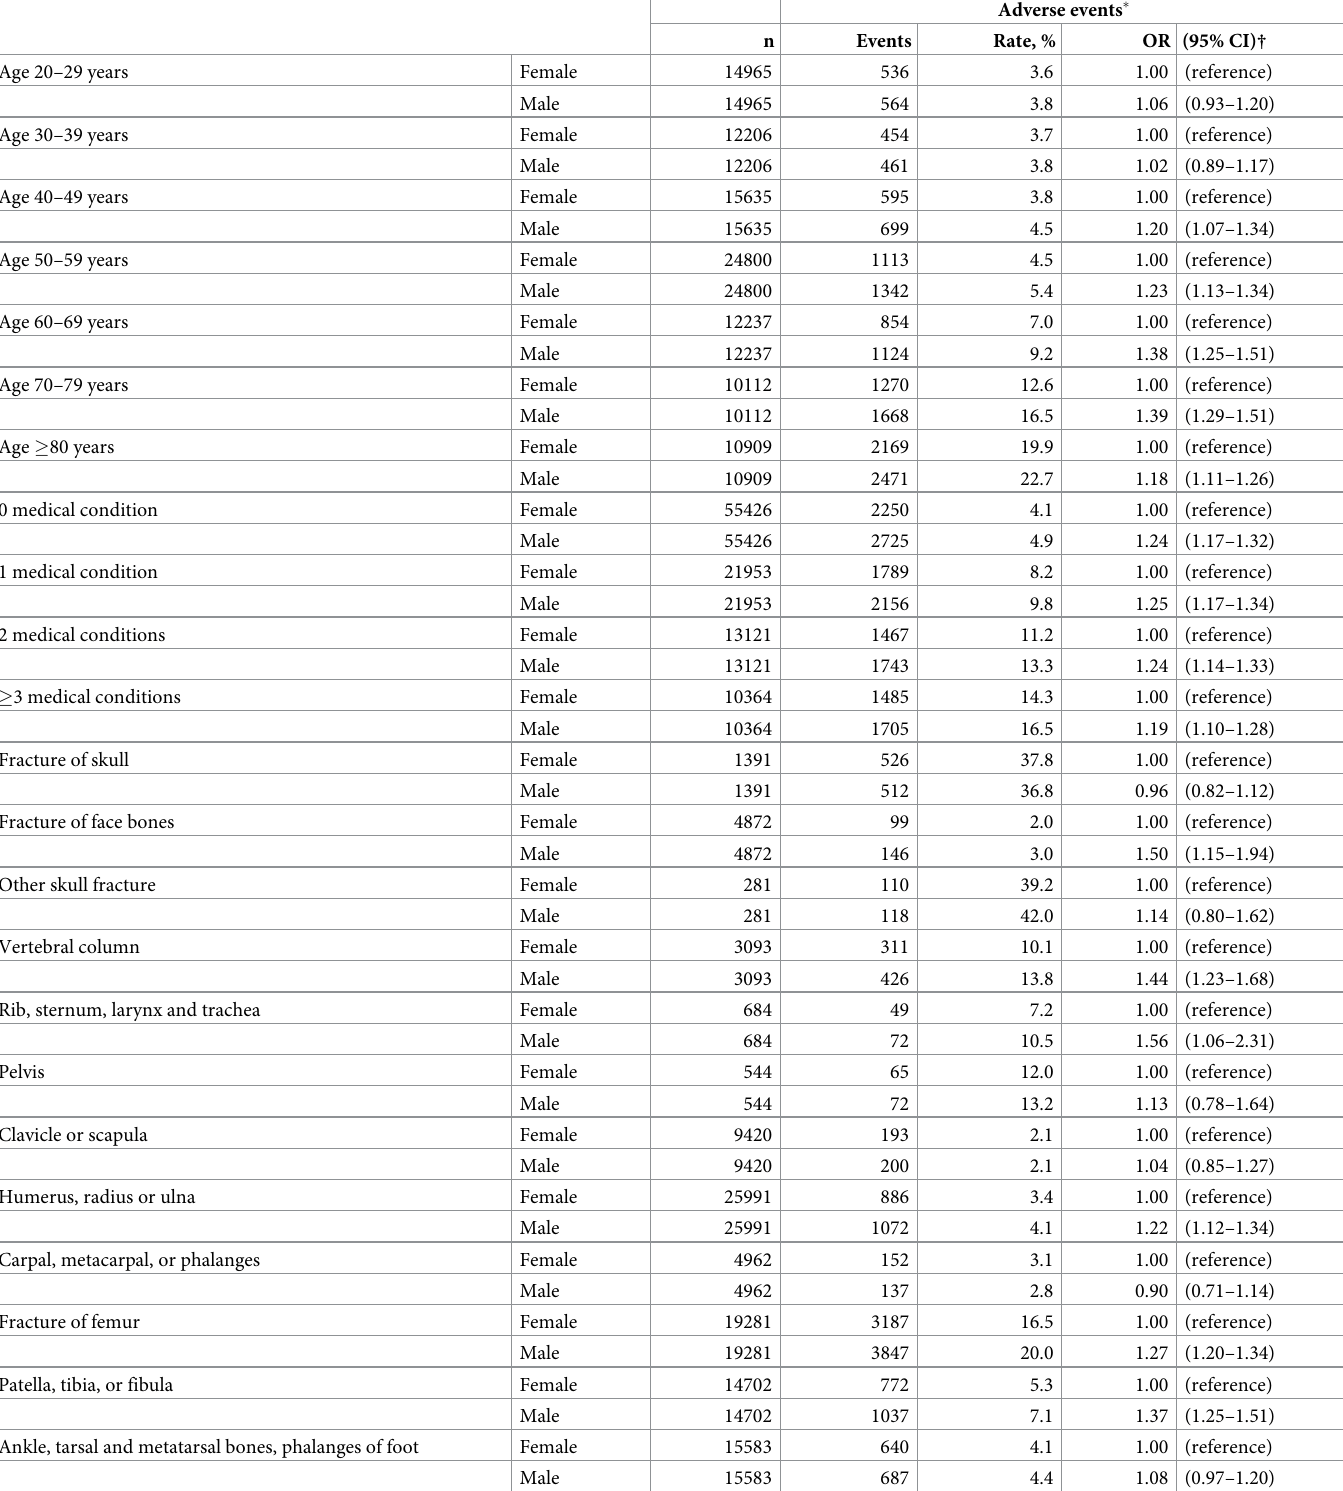
Table 4. The stratified analysis for the risk of adverse events after fracture associated with